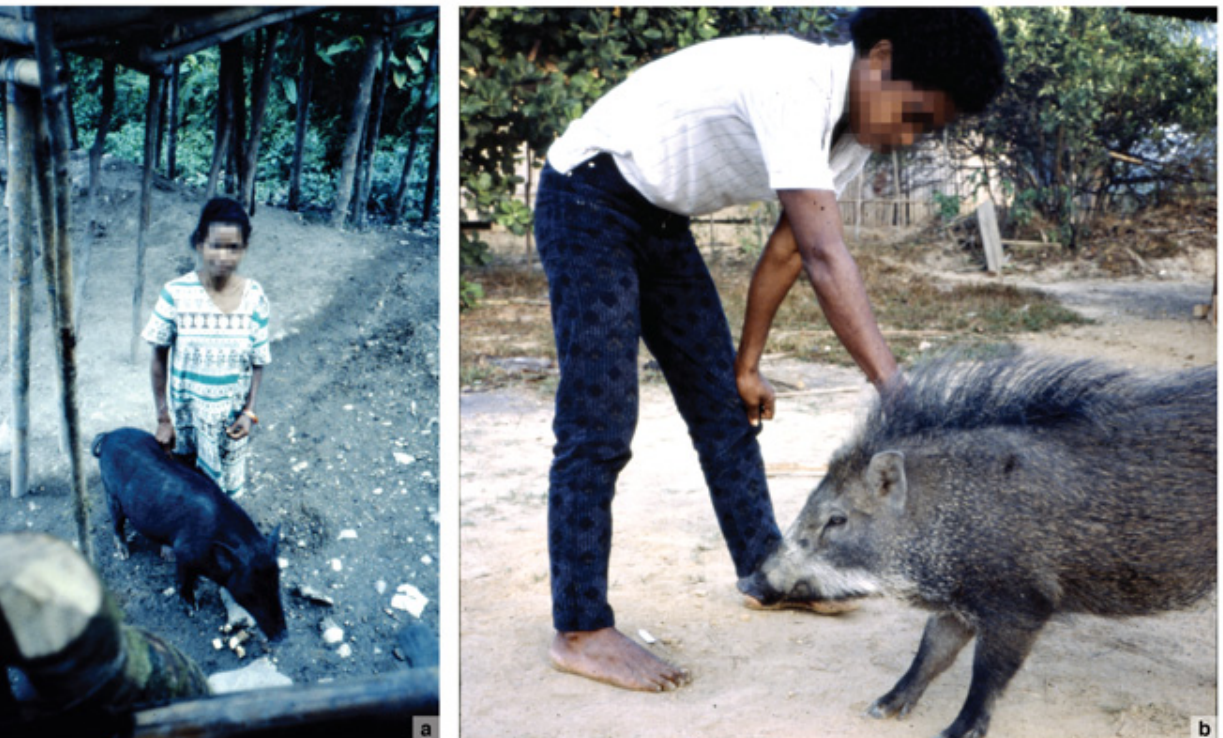
Figure 5. Wild pig companion animals on Seram, Indonesia. ( a ), Pepina with one of the wild pigs she befriended, a member of the family group that lived in the forest near her isolated home; ( b ), wild S. scrofa pig reared as a pet from an early age in Melinani village. Credit: A.A. Macdonald. Macdonald is uncertain whether Pepina ever adopted any of the wild piglets from this forest ‐ dwelling family group (A. Macdonald, pers. comm. 2021). Elsewhere in Seram,